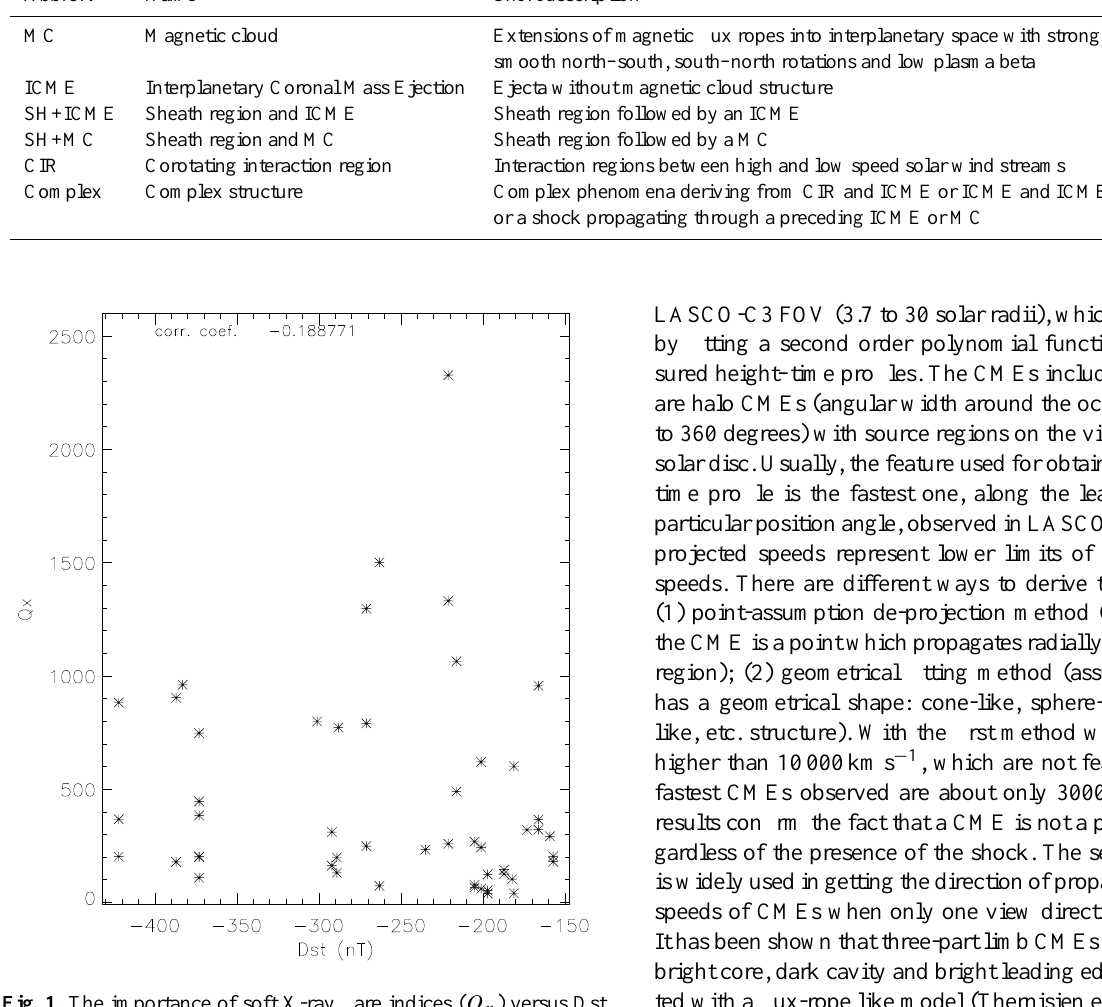
Fig. 1. The importance of soft X-ray flare indices ( Q x ) versus Dst indices. For the 28 October 2003 flare, Q x = 7000 and is not plotted in this figure in order to better show the spread of data points.